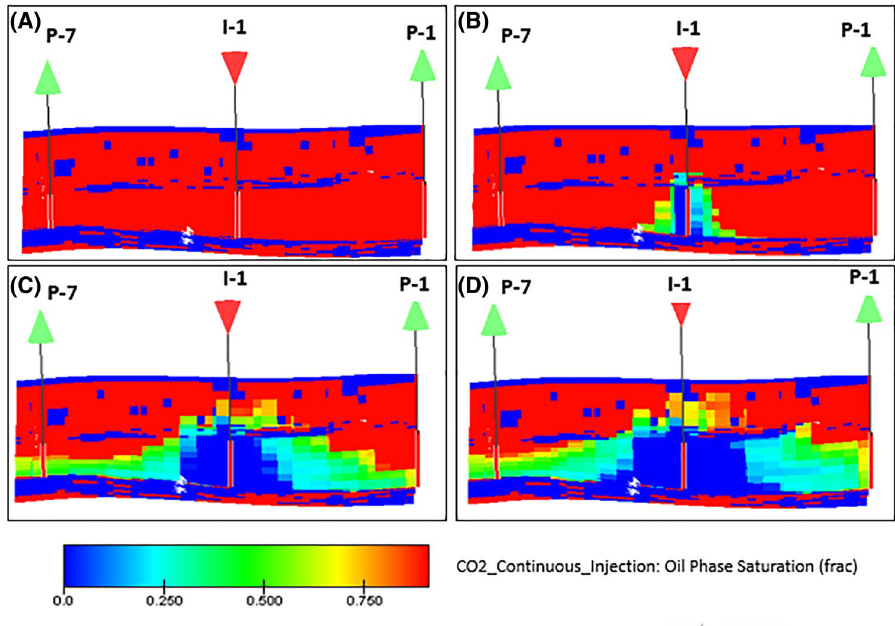
Fig. 11 Oil saturation on a plane intercepted by the wells P-7, I-1 and P-1. a Starting oil saturation. b – d oil satura- tion after 6 months, 5 years and 10 years of production,